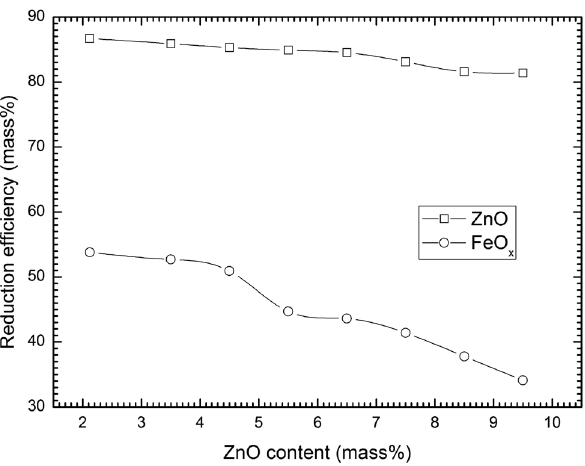
Fig. 9: The relation between the reduction efficiencies of ZnO and FeO x with the initial ZnO